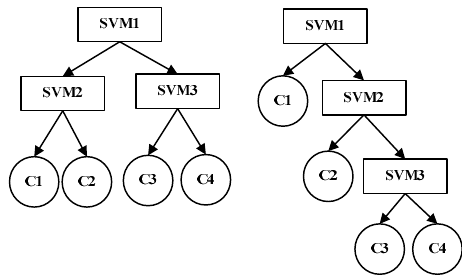
Figure 1. Multiple classification structure. (a) Complete and (b) partial BT-SVM.